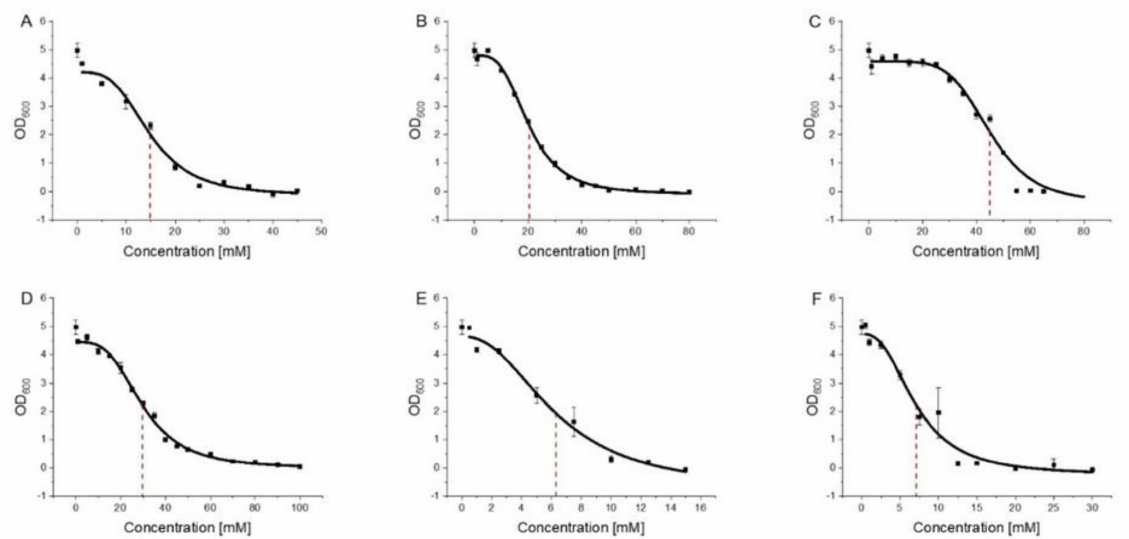
Figure 4. Determination of MIC50 values. The OD 600 was plotted against the substance concentration and a dose-response fit was performed for ( A ) 2-PEtOH, ( B ) phenylacetic acid, ( C ) phenyllactic acid, ( D ) Tyrosol, ( E ) methyl phenylacetate, and ( F ) 1-hexanol (n = 3, ± SD). The corresponding MIC50 values are given in Table